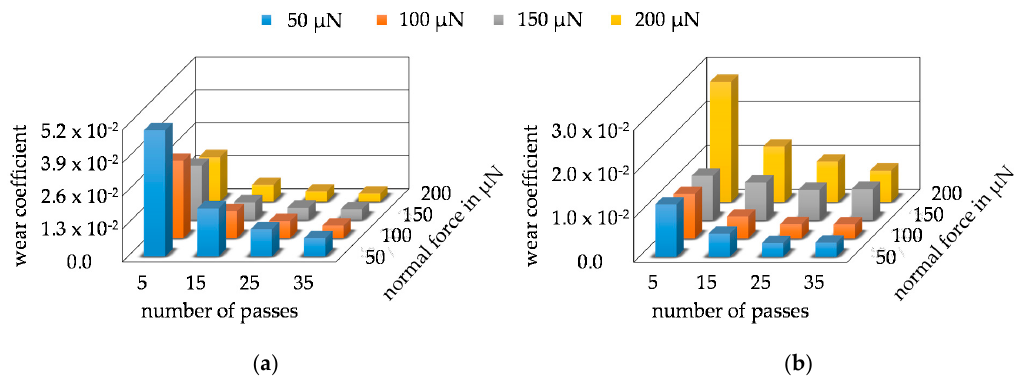
Figure 13. Development of the calculated average values of the coefficient of wear of the respective parameter combination as a 3D bar chart: ( a ) Mo-coating; ( b ) MoO 3 -coating.